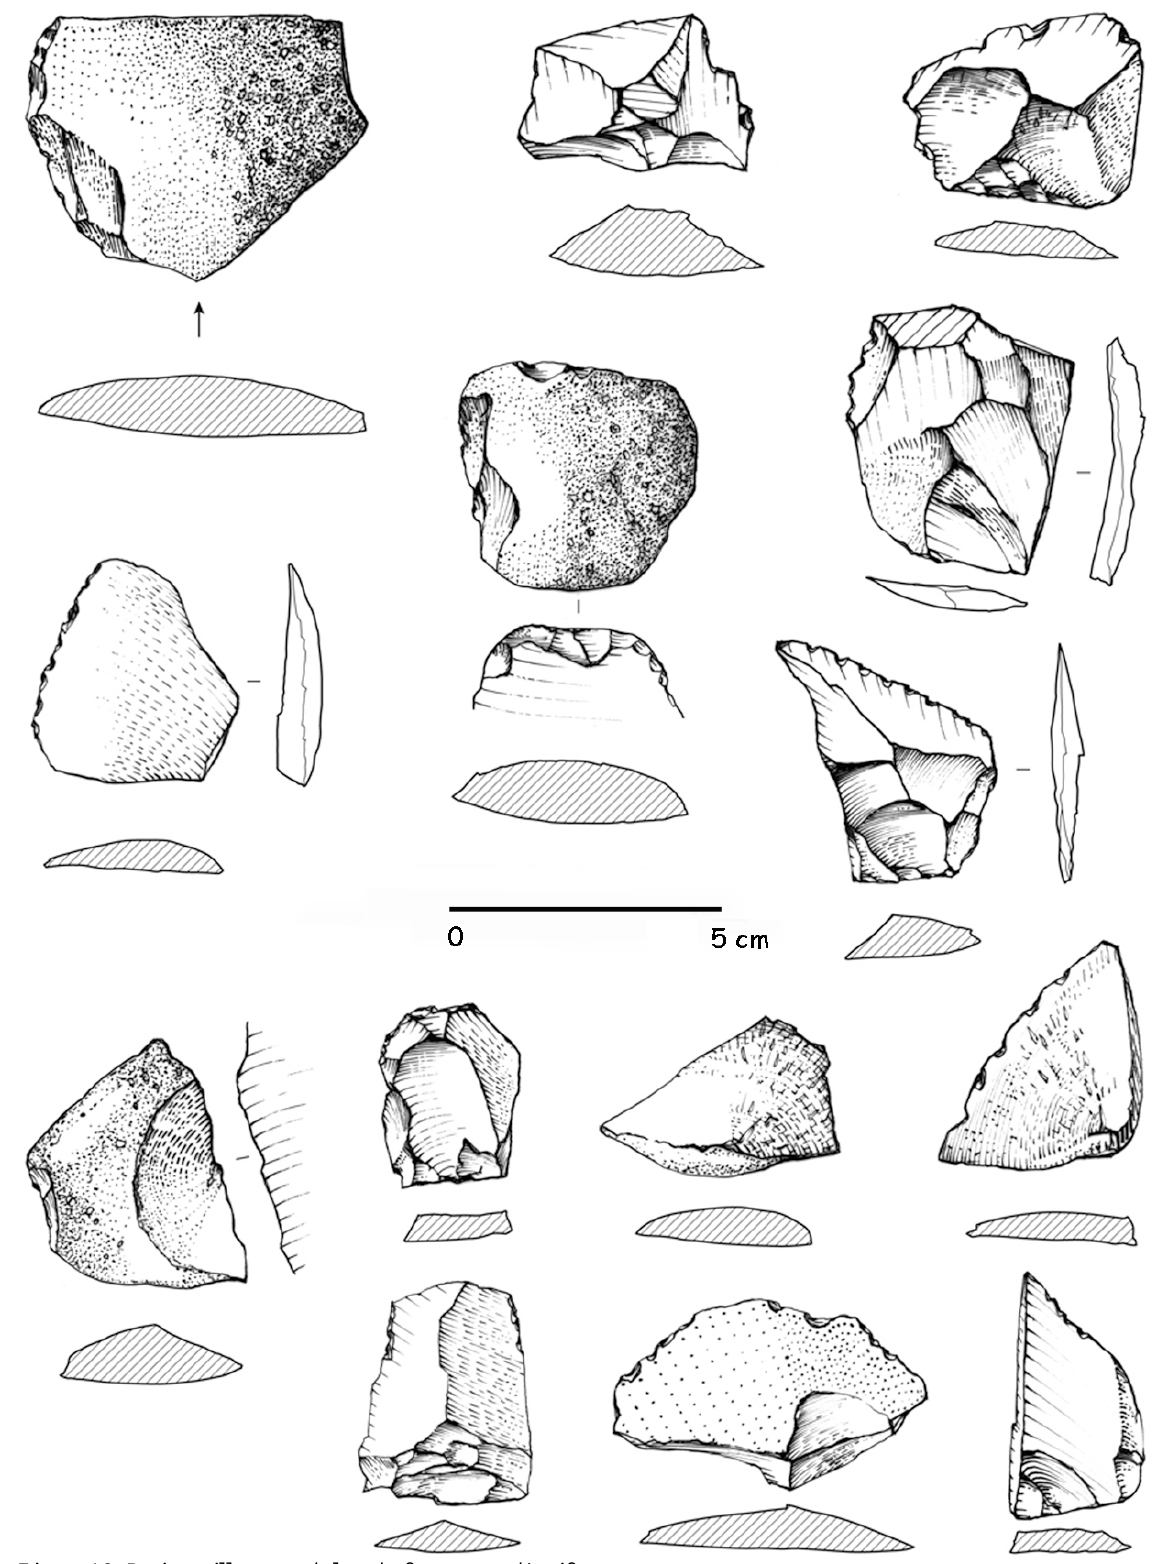
Figure 18. Petit outillage sur éclats de façonnage d’uniface. Figure 18. Small flake tools from unifacial